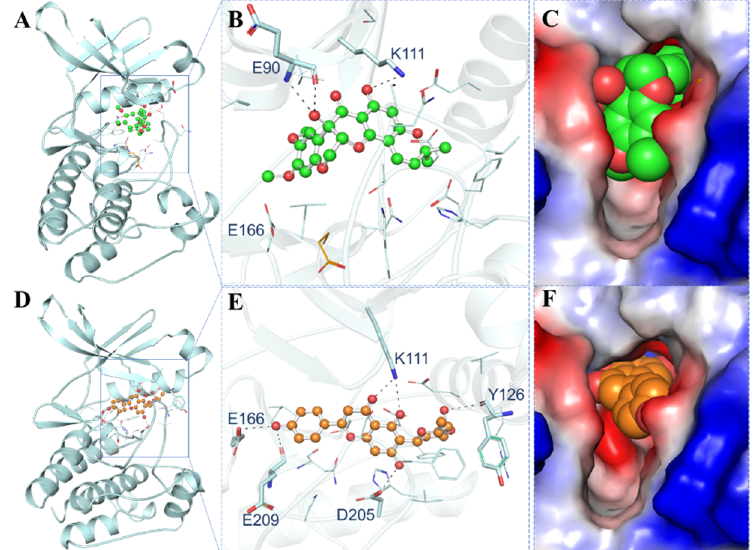
Figure 1. Representation of PDPK1 in complex with the elucidated compounds. ( A ) Cartoon representation of PDPK1 with 11-Hydroxytephrosin. ( B ) Magnified cartoon representation of PDPK1 with 11-Hydroxytephrosin. ( C ) Charged view of PDPK1 binding pocket space-filled by 11-Hydroxytephrosin. ( D ) Cartoon representation of PDPK1 with Torosaflavone A. ( E ) Magnified cartoon representation of PDPK1 with Torosaflavone A. ( F ) Charged view of PDPK1 binding pocket space-filled by Torosaflavone